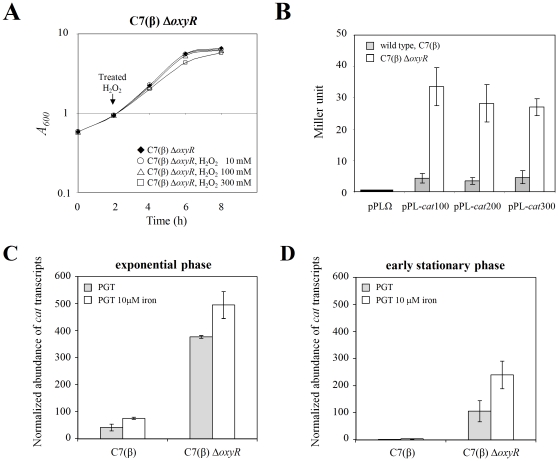
The C. diphtheriae C7(β) ΔoxyR mutant showed increased resistance to H2O2, increased activity of cat promoter reporters, and increased cat transcript abundance.A: Growth of the C7(β) ΔoxyR in high-iron PGT medium without (⧫) and with 10 mM H2O2 (○), 100 mM H2O2 (▵), or 300 mM H2O2 (□) added during exponential growth (downward arrow). B: β-galactosidase activities during exponential phase growth in high-iron PGT medium of wild-type C. diphtheriae C7(β) (shaded bars) and C7(β) ΔoxyR (open bars) harboring plasmid pPLΩ, pPL-cat100, pPL-cat200 or pPL-cat300. Error bars show standard deviations of the mean (n = 3). C and D: Normalized abundance of cat transcripts in wild-type C. diphtheriae C7(β) and the C7(β) ΔoxyR mutant during exponential phase growth (C) or early stationary phase growth (D) in low-iron PGT medium (shaded bars) or high-iron PGT medium (open bars). Error bars show standard deviations of the mean (n = 3).